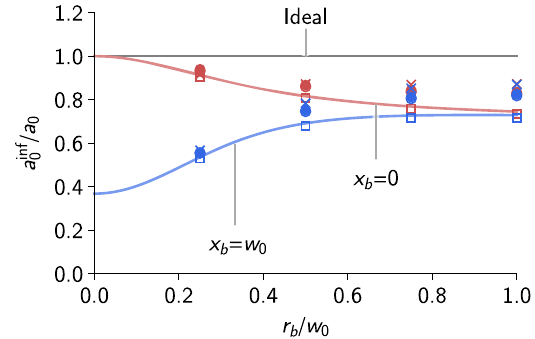
FIG. 6. The inferred a 0 as a fraction of the true a 0 , for the collision geometry shown in Fig. 4, for different beam radii r from simulations with quantum (filled circles), modified classical (open circles), classical (crosses), and no RR (squares); and as predicted by Eq. (6) for x